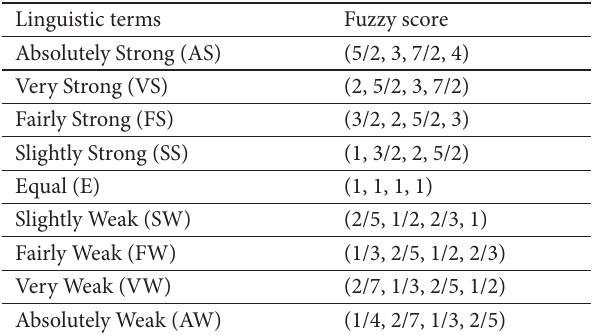
Table 1. Fuzzy evaluation scale for the weights Linguistic